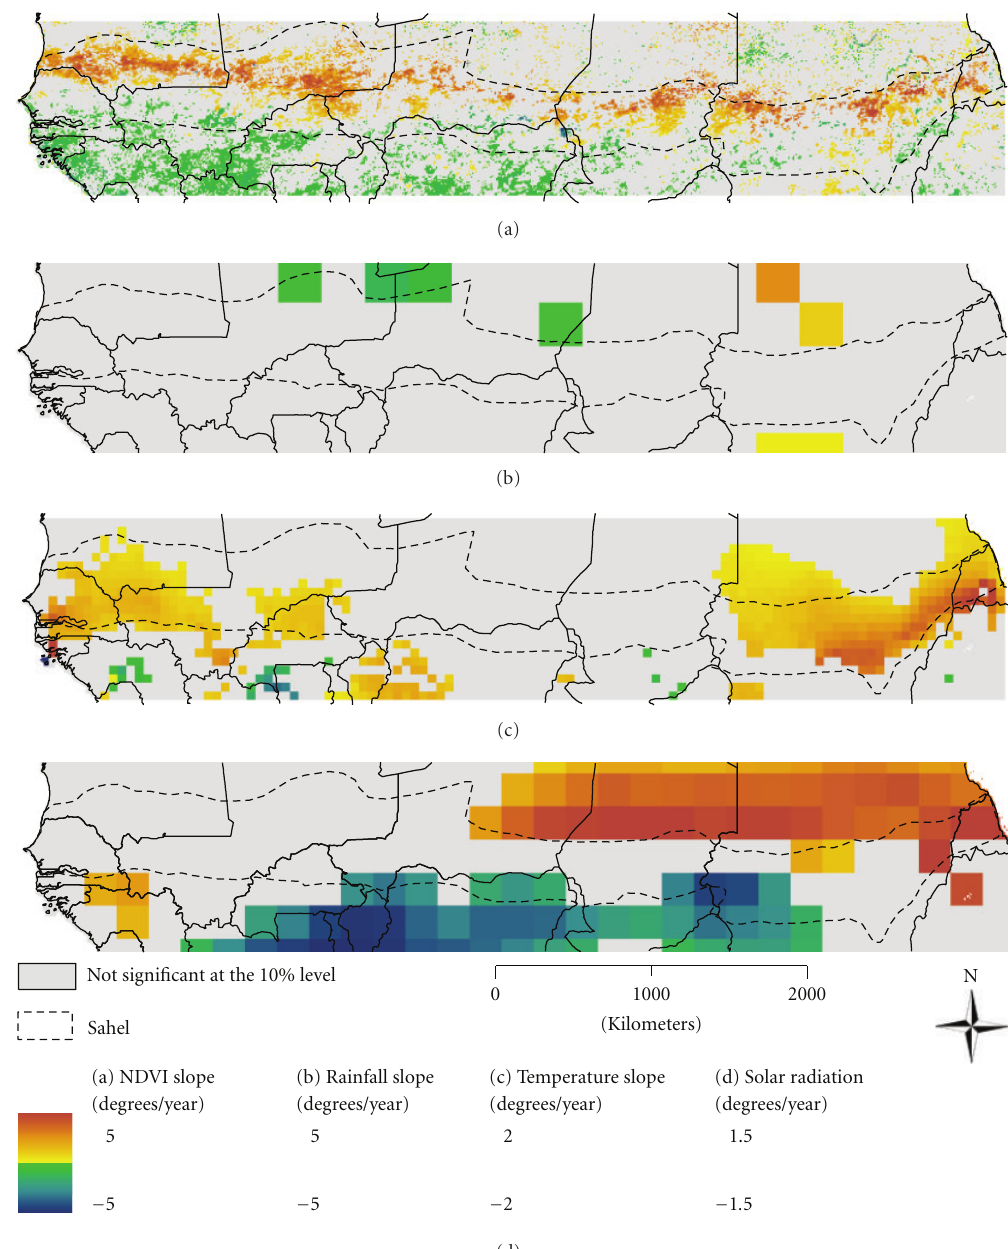
Figure 7: STA phase 1 images, Sahel 1982–2007 (only slopes significant at the 10% level). Changes in the phase of the seasonal (a) NDVI curve, (b) rainfall, (c) air temperature, and (d) surface downward solar radiation